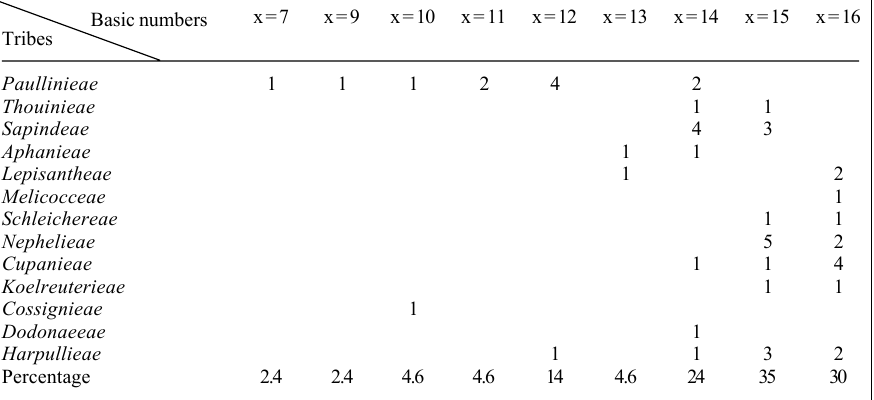
Table II - Distribution of basic chromosome numbers of 42 studied genera in 13 tribes of Sapindaceae .